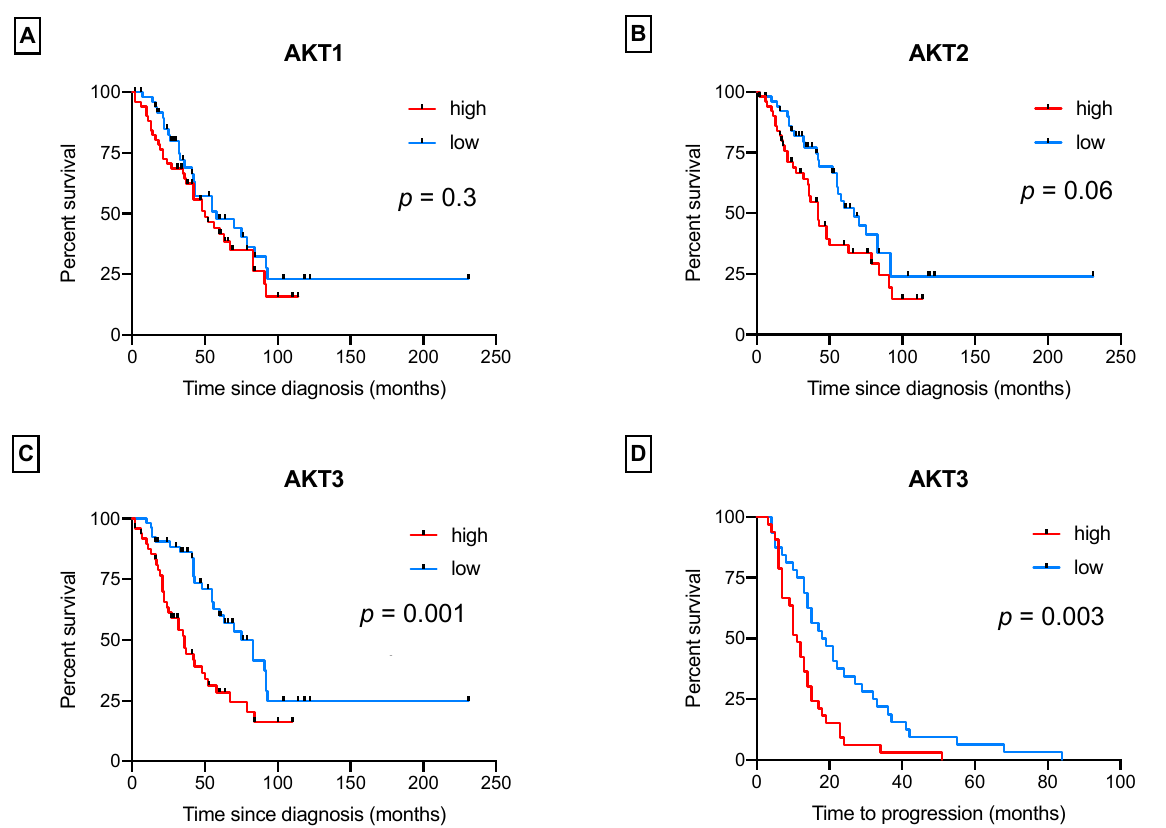
Figure 1. Kaplan–Meier survival curves for AKT isoforms expression, notably, overall survival for AKT1 ( A ), AKT2 ( B ) and AKT3 ( C ); ( D ) progression-free survival (PFS) for p AKT3 expression.